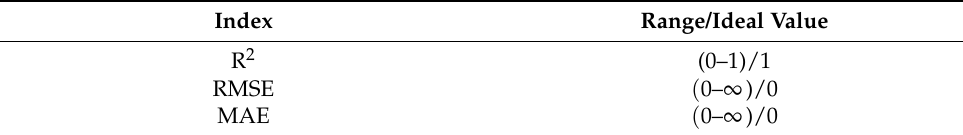
Table 3. Ideal values of performance